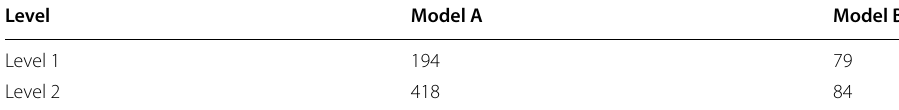
Table 2 Number of categories in different classification levels Level